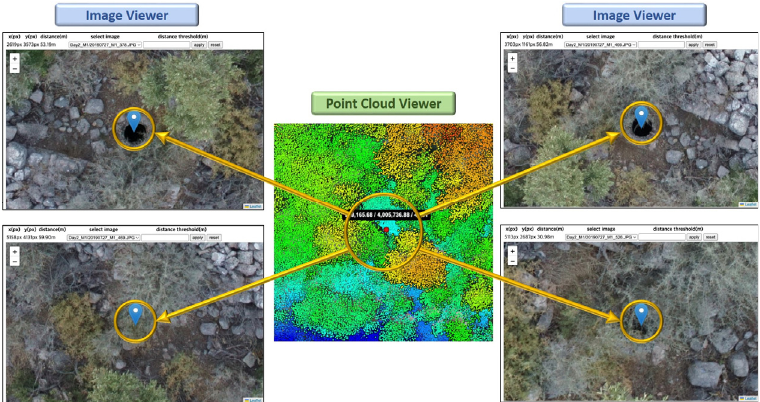
Figure 20. Illustration of an object point within a cistern projected onto different images (elevation variations cause relief displacements, making the cistern invisible in some of the images—lower left and lower right).